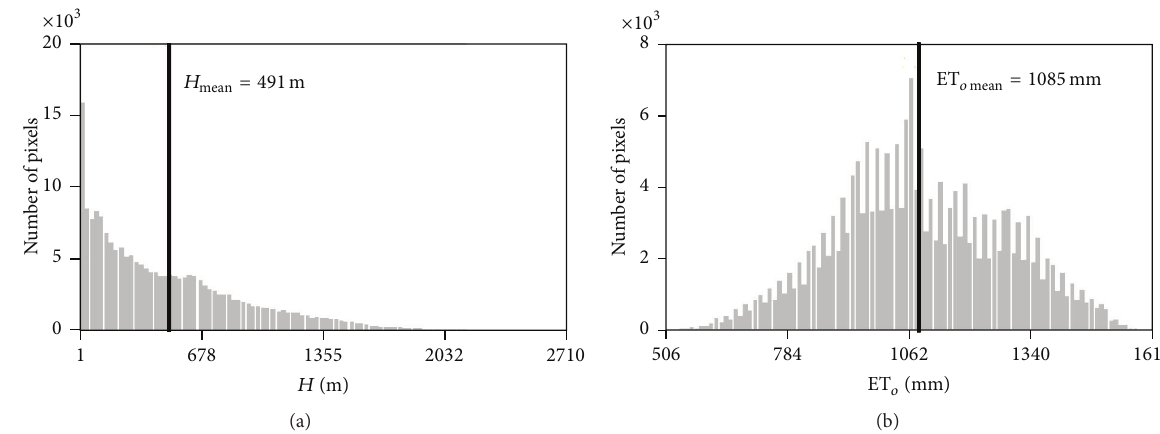
Figure 2: Frequency analysis of the spatial variation of (a) elevation 𝐻 and (b) mean annual ET 𝑜 estimated by the ASCE standardized Penman-Monteith method for the period 1950–2000.